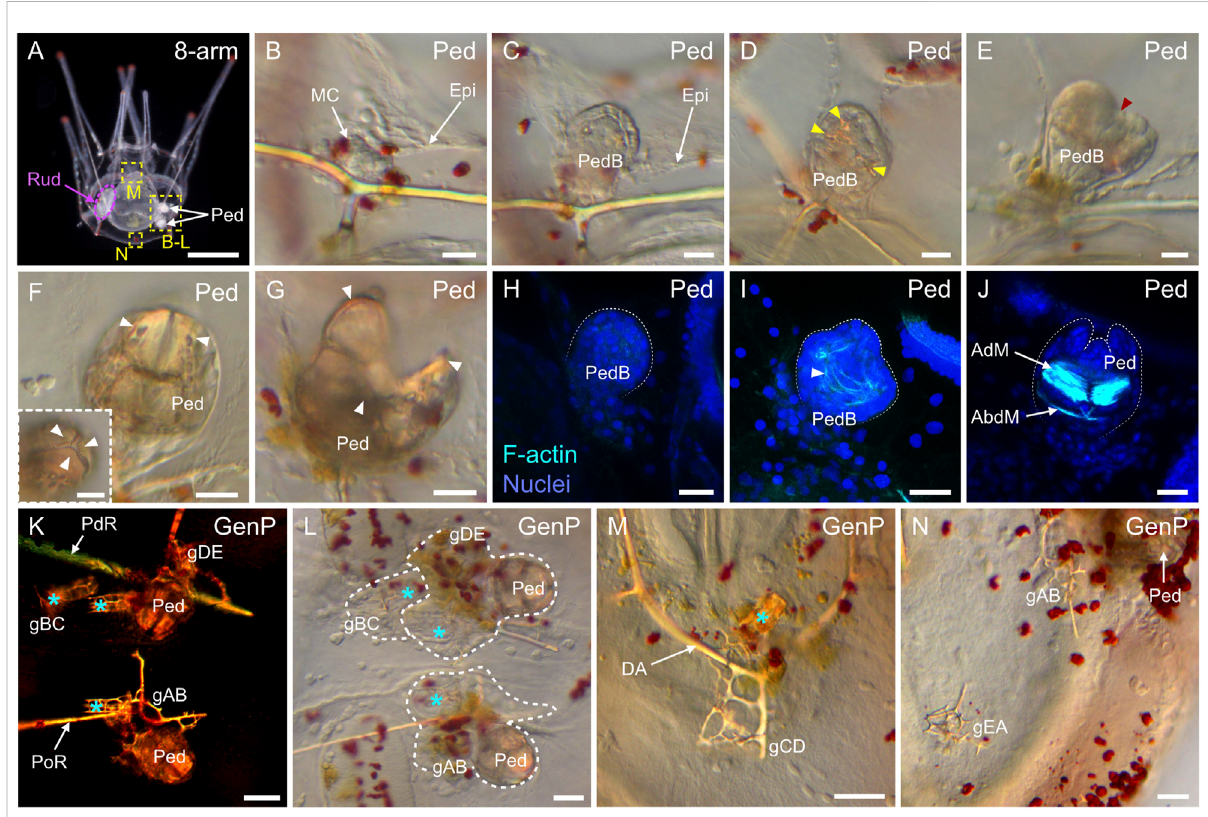
FIGURE 14 Development of the pedicellariae and the genital plates in Paracentrotus lividus larvae. In (A – N) , images are from larvae at the 8-arm pluteus stage (8-arm). In (A) , the image was acquired using dark- fi eld light microscopy. In (B – G,L – N) , images were obtained using bright- fi eld light microscopy. In (H – J) , images are maximum intensity projections of confocal z-stacks of larvae co-labeled for F-actin (muscles; cyan) and DNA (nuclei; blue), and they correspond to projections of the entire pedicellaria. In (K) , the image was taken using polarized light to highlight the skeletal elements. In (A) , the larva is in anterior view, with the ventral side up and the left side to the left. (B – N) Close-ups of the regions outlined by yellowboxesin (A) . (B – J) Close-upsofpedicellariae(Ped). (K – N) Close-upsofgenitalplates(GenP).In (A) ,thepurpledottedlinedelineatestheadult rudiment on the left side of the larva. In (D) , yellow arrowheads indicate the skeletal elements developing inside the pedicellaria bud. In (E) , the red arrowhead shows the individualization of the three lobes within the bud. In ( (F) , (F) inset, (G) ), white arrowheads mark the three jaws of the pedicellaria, which can beeither closed like in (F) and ( (F) inset) or open like in (G) . In (H – J) , white dotted lines outline thepedicellariabud in (H – I) or the pedicellaria jaws in (J) . In (I) , the white arrowhead points to the fi rst muscle fi bers appearing within a pedicellaria bud. In (K – M) , cyan asterisks indicate the position of juvenile spines associated with the genital plates. In (L) , white dotted lines delineate the genital plates and their associated juvenile spines developing in the vicinity of pedicellariae. Scale bar: (A) 200 μ m; ( (B – G) , (F) inset) 15 μ m; (H – J,K – M) 30 μ m; (N) 50 µm.